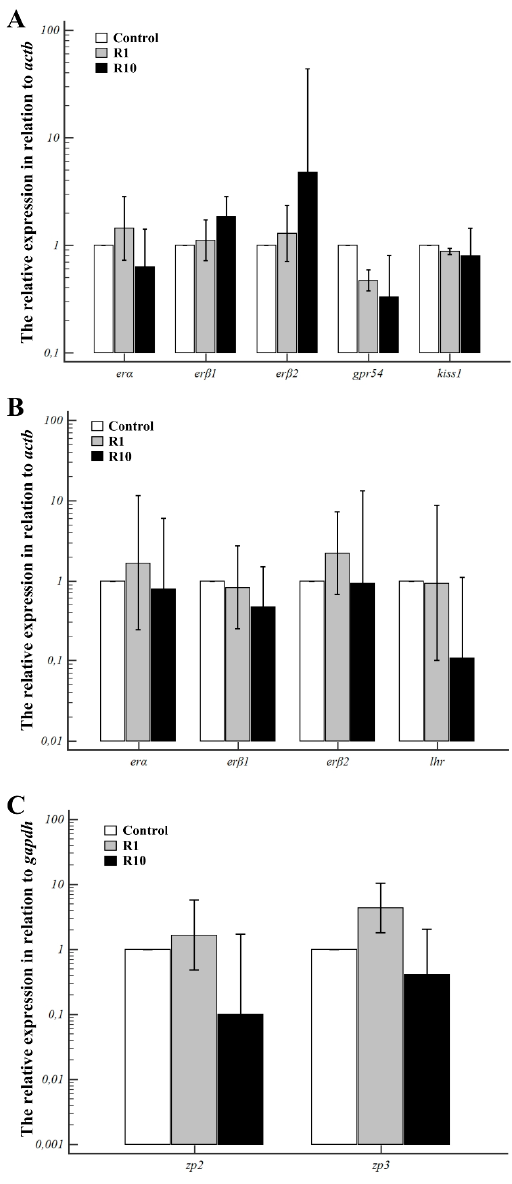
Figure 2. Alternation in kiss-1 , gpr54 , er α , er β 1 , er β 2 mRNA transcript abundance in crucian carp ( Carassius carassius ) pituitary ( A ), lhr , er α , er β 1 , er β 2 and zp2 , zp3 mRNA transcript abundance in ovarian follicles ( B , C ) exposed to Roundup at a concentration of 1 (R1) and 10 ng/mL (R10). Data were shown as a logarithm of relative expression compared to β -actin ( A ) and gadph ( B , C ) and expressed as means ± SD ( n = 3 wells/each group, 2 pituitaries/well, n = 5 wells/each group, ~150 ovarian